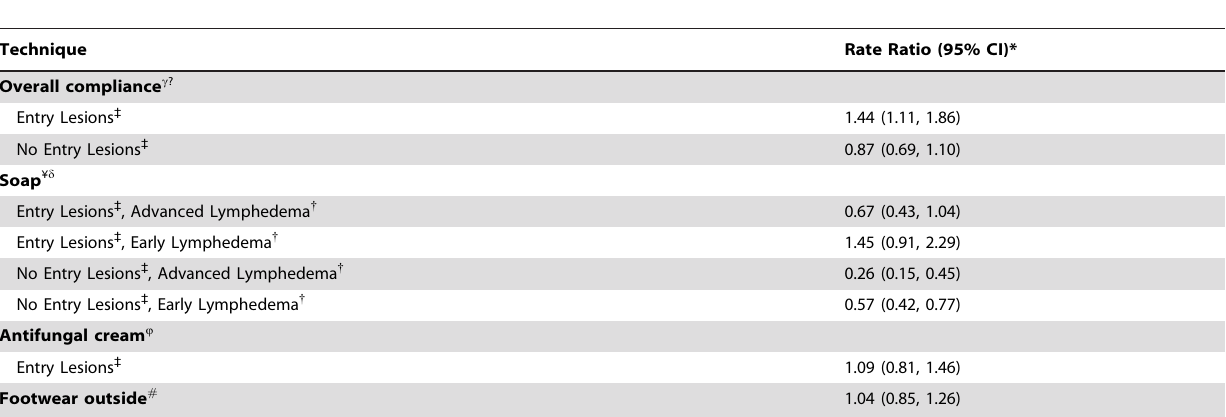
Table 7. Association between compliance to lymphedema management techniques at the previous time point and 30-day rate of ADLA episodes, Khurda District, Odisha State, India, July 2009–July